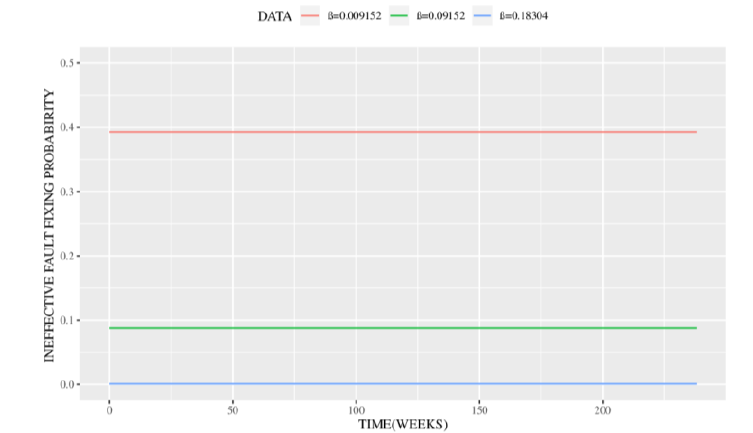
Figure 7. Imperfect fault fixing probability using exponential model in Eq.